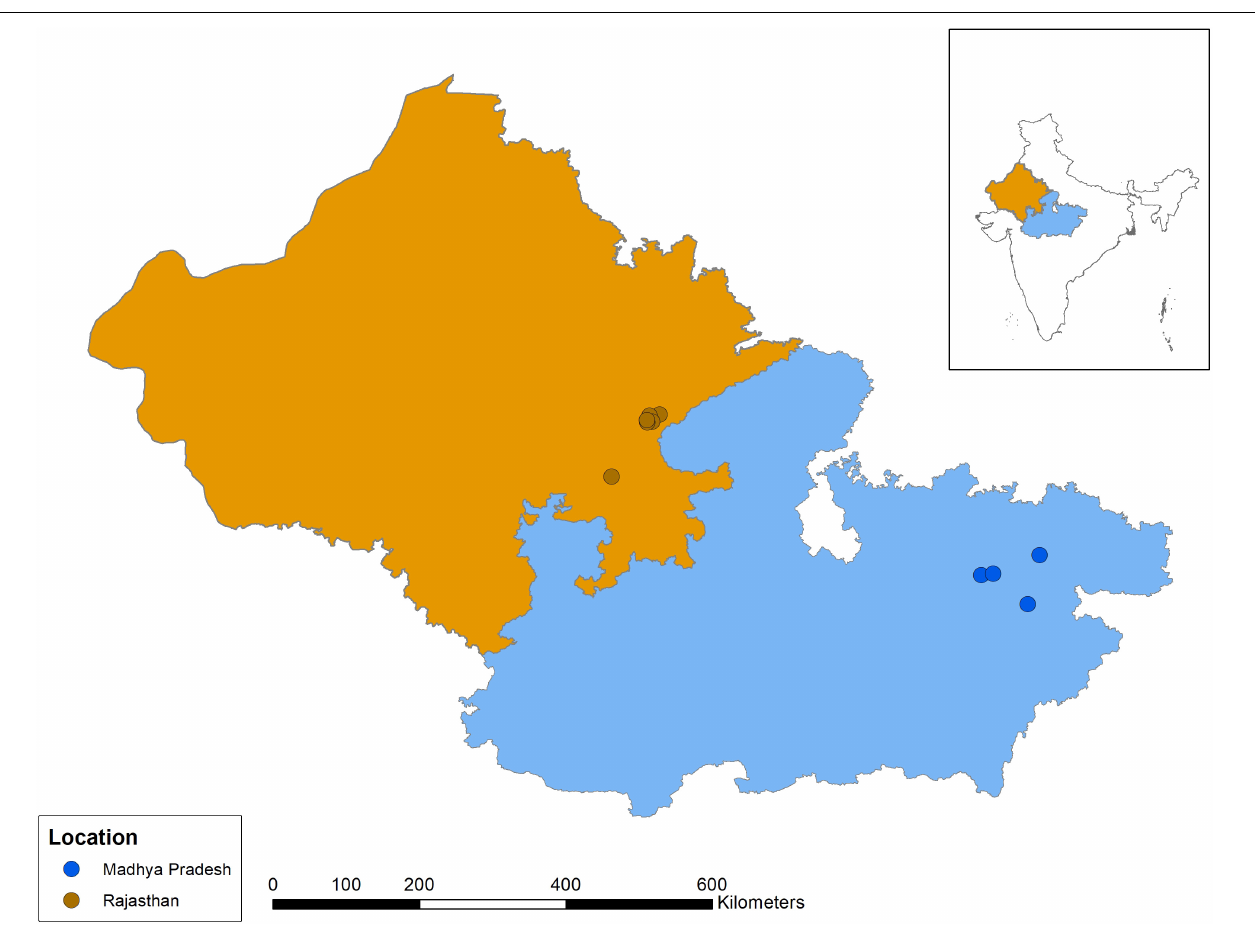
FIGURE 1 | Map of our study sites (points) in the Indian states of Madhya Pradesh (blue, East) and Rajasthan (orange,